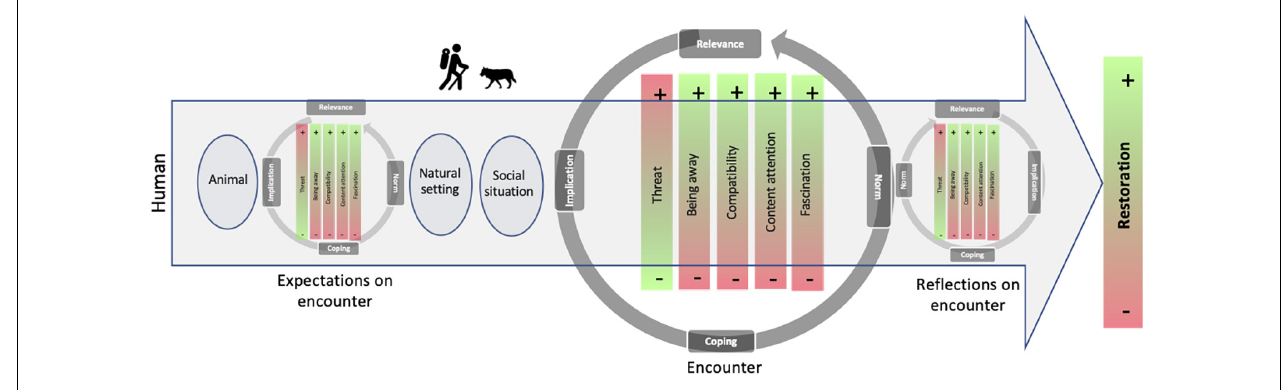
FIGURE 2 | A description of how an encounter with wildlife during a visit to a natural setting can lead to enhanced or reduced psychological restoration. Given the possibility of an encounter with a particular species of animal (shown with the silhouettes), expectations regarding the role of the encounter in the desired restorative experience will get shaped by general, cultural and personal appraisals of human-animal interactions, what is known of the natural setting and the social situation (e.g., whether one will be going alone or in the company of others). As with the formation of expectations, appraisals during the encounter concern matters of relevance, implications, coping potential, and norm congruence (Scherer, 2001) as related to components of restorative experience - threat, being away, compatibility, fascination and attention to content – described in attention restoration theory (Kaplan and Kaplan, 1989) and stress recovery theory (Ulrich, 1983). Subsequent reflection on the wildlife encounter would involve similar appraisals and shape the outcomes experienced after the visit as well as future